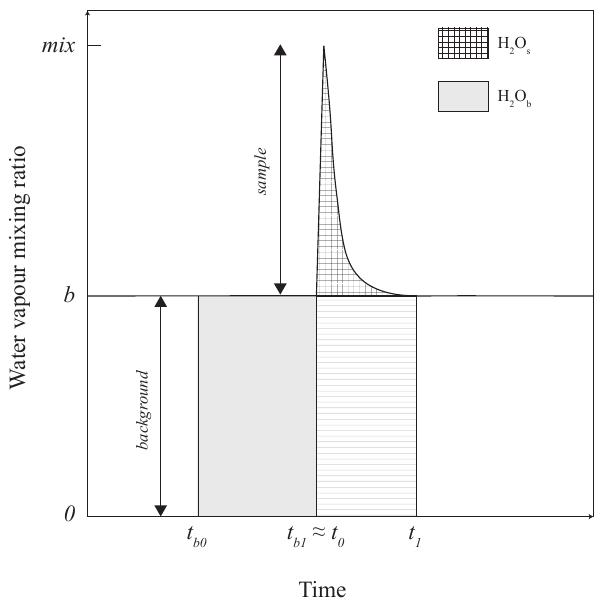
Figure 10. Schematic diagram illustrating the evaluation protocol (see text for